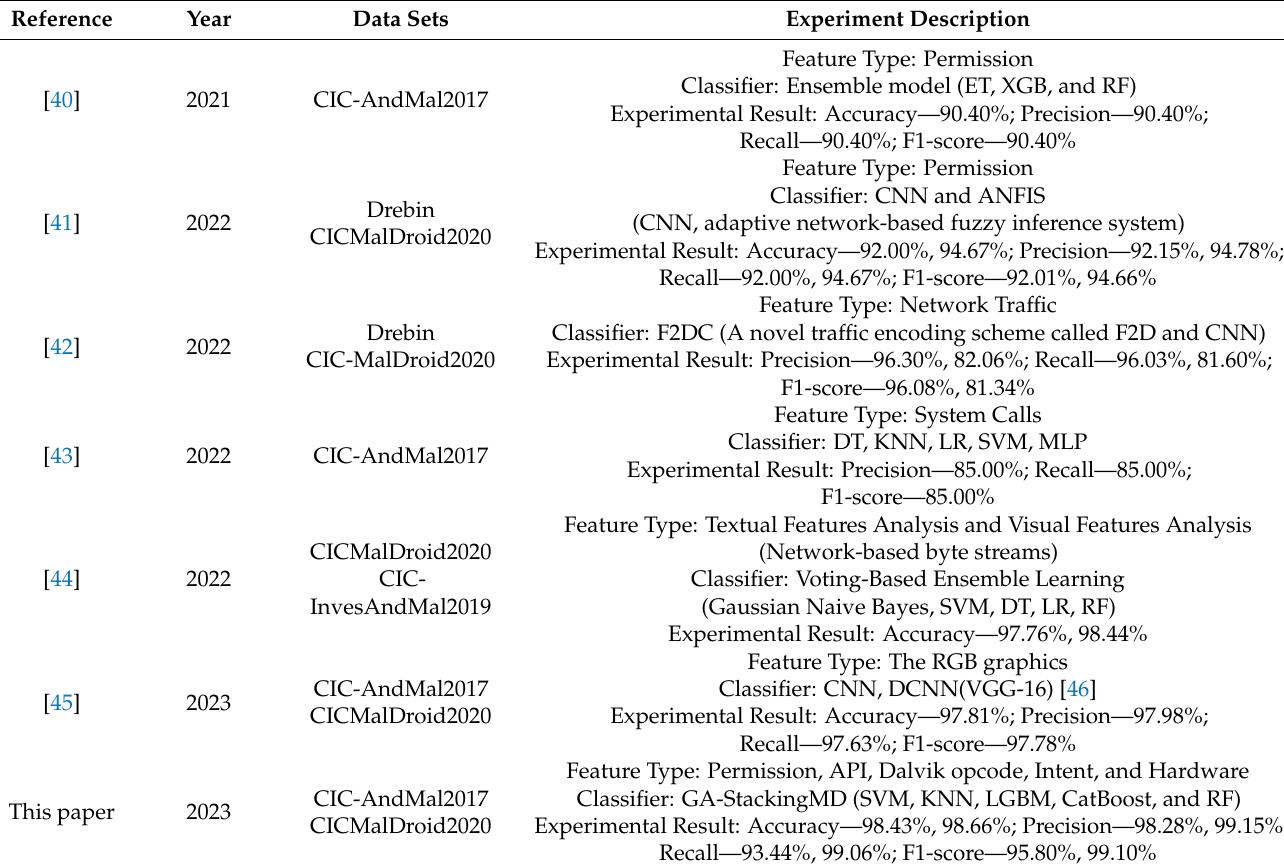
Table 6. GA-StackingMD comparison with the relevant studies in the